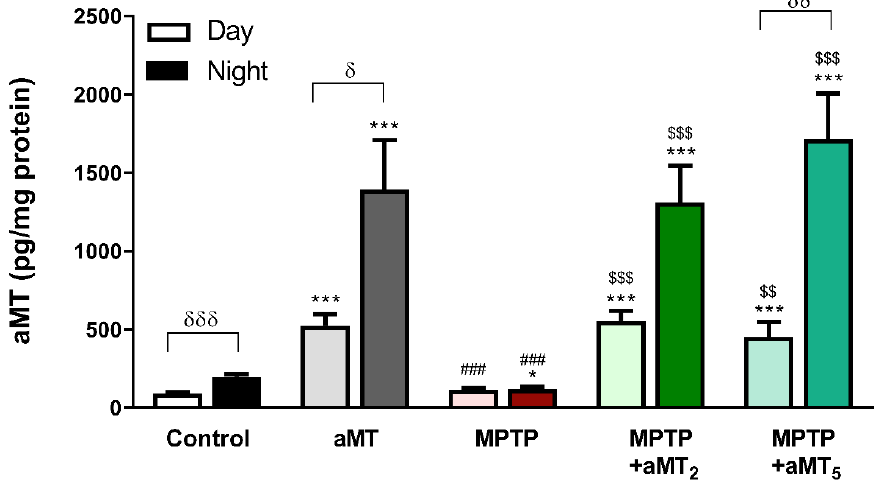
Figure 2. Endogenous levels of melatonin in zebrafish embryos during the day (light color) and during the night (dark color). Control, untreated embryos; aMT, control embryos treated with 1 μM melatonin; MPTP, embryos incubated with 600 μM MPTP; MPTP+MT 2 , embryos treated with 600